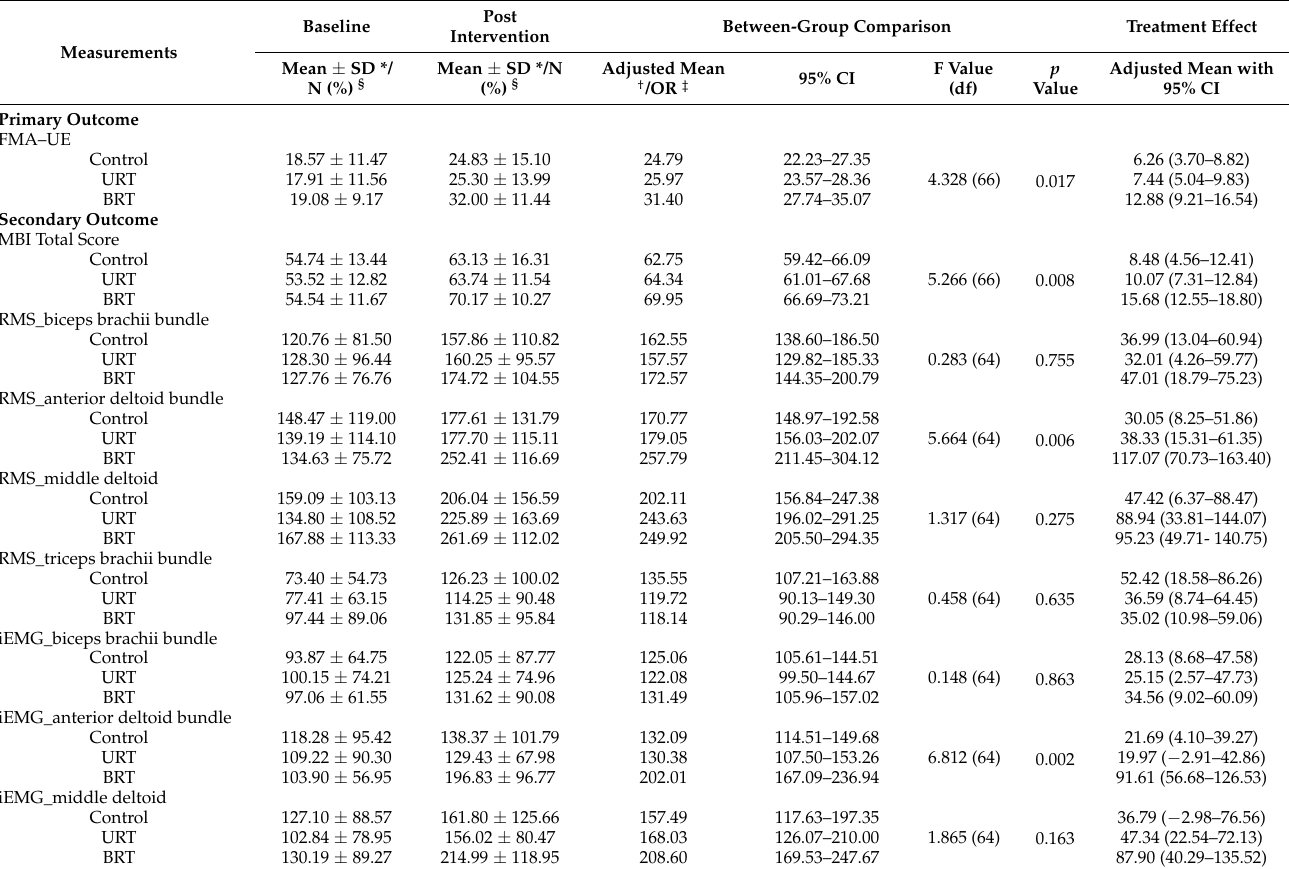
Table 2. Clinical outcome measures and inferential